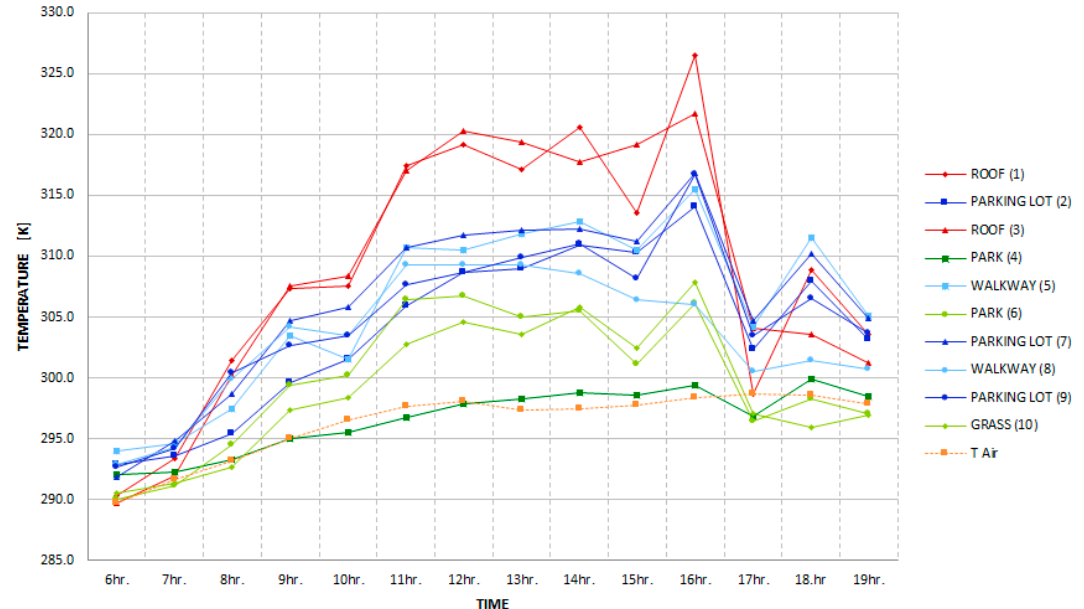
ISPRS Int. J. Geo-Inf. 2020 , 9 , x FOR PEER REVIEW Figure 6. Measured LSTs in 10 selected locations in the study area on 25 June 2020.